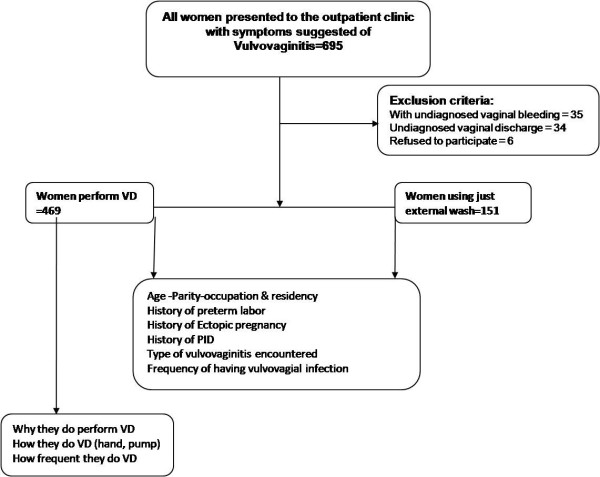
Study flowchart.